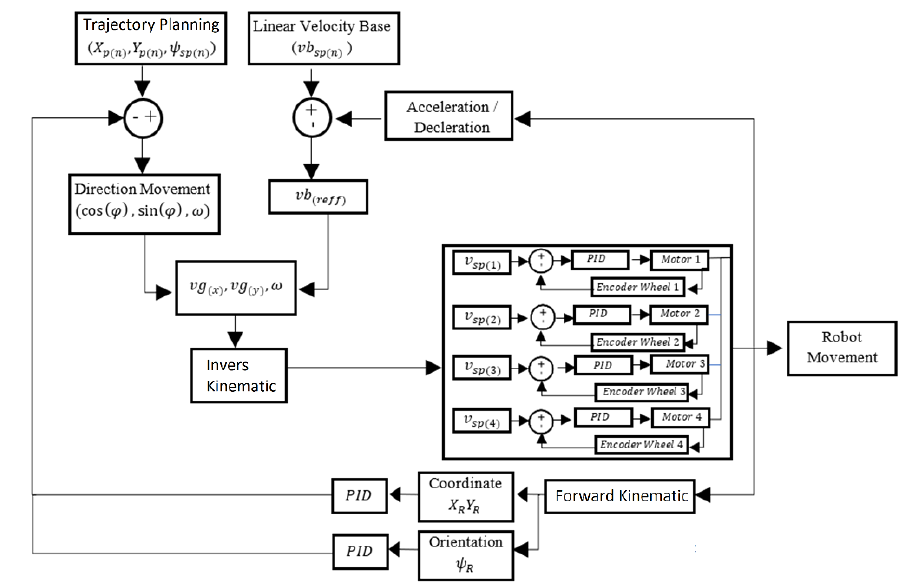
Figure 8. Control Block Diagram.